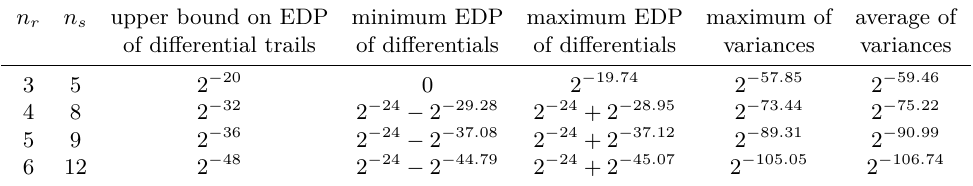
Table 2: EDP of single-tweak differential trails, highest and lowest EDP found for single- tweak differentials and variances of EDP for 3 to 6 core rounds. n r and n s denotes the number of core rounds and the minimum number of active S-boxes in the differential trails. The variance , is the variance for EDP of all differentials with the same input